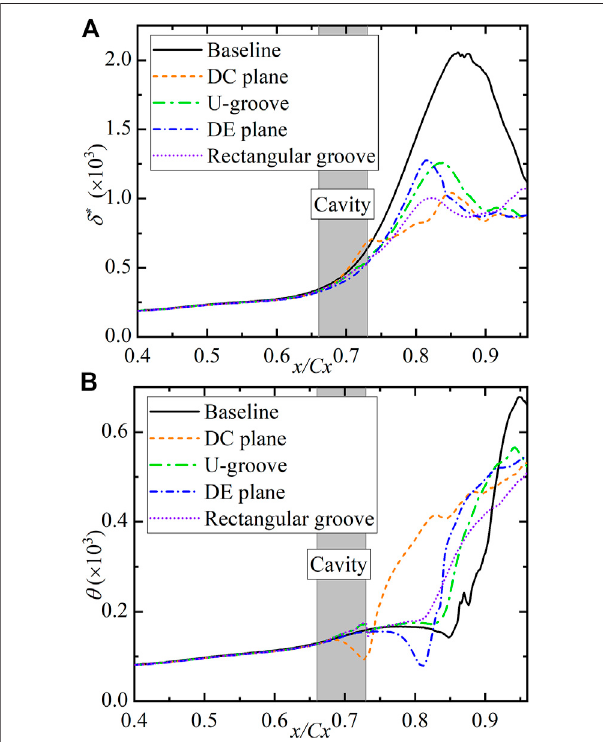
FIGURE 8 | Time- and spanwise-averaged (A) displacement thickness and (B) momentum thickness distribution for various surfaces.